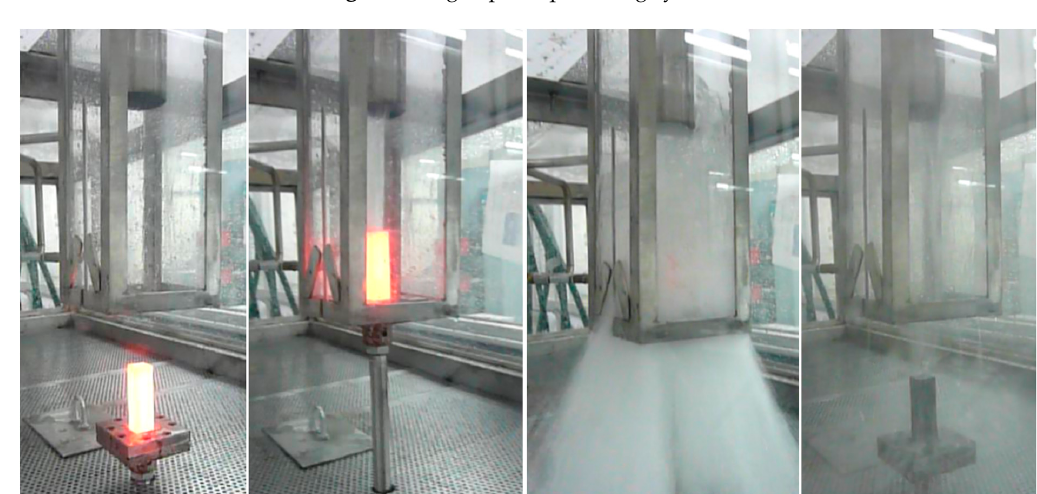
Figure 2. High-speed quenching chamber in operation.